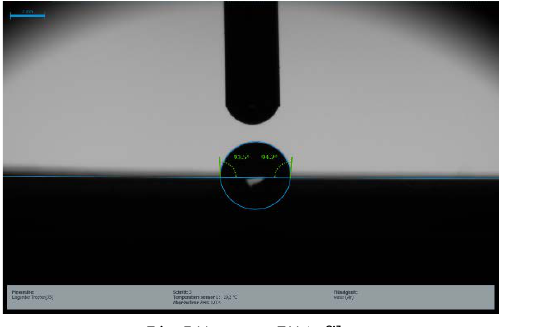
Fig. 5 Water on EVA film Fig. 6 Spray paint on EVA film